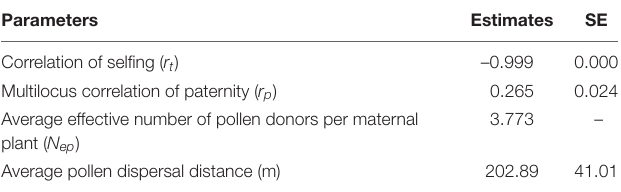
TABLE 4 | Mating system parameters for Bombax ceiba